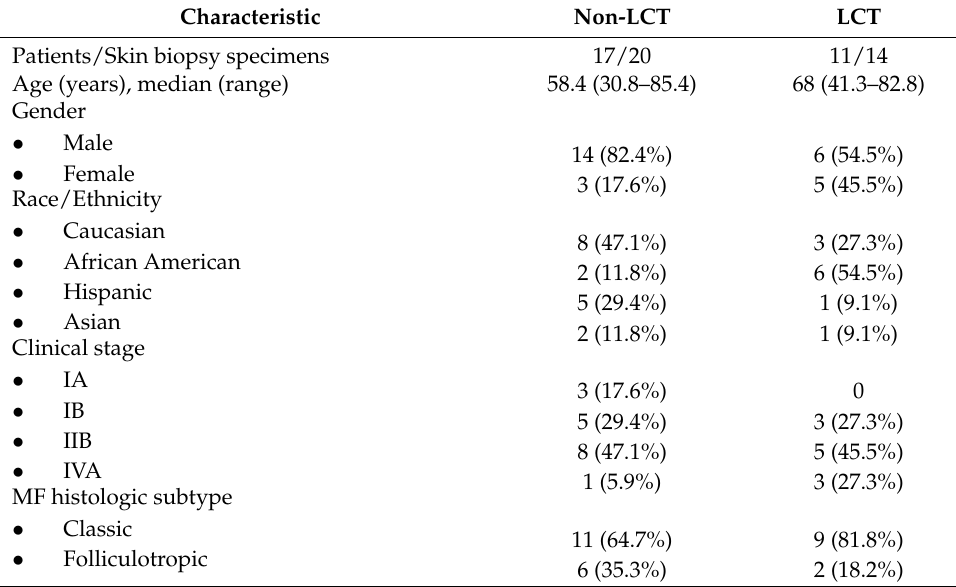
Table 1. Clinical features of 28 patients with mycosis fungoides with and without large cell transfor- mation (there is little or no prior past therapies). Characteristic Non-LCT Patients/Skin biopsy